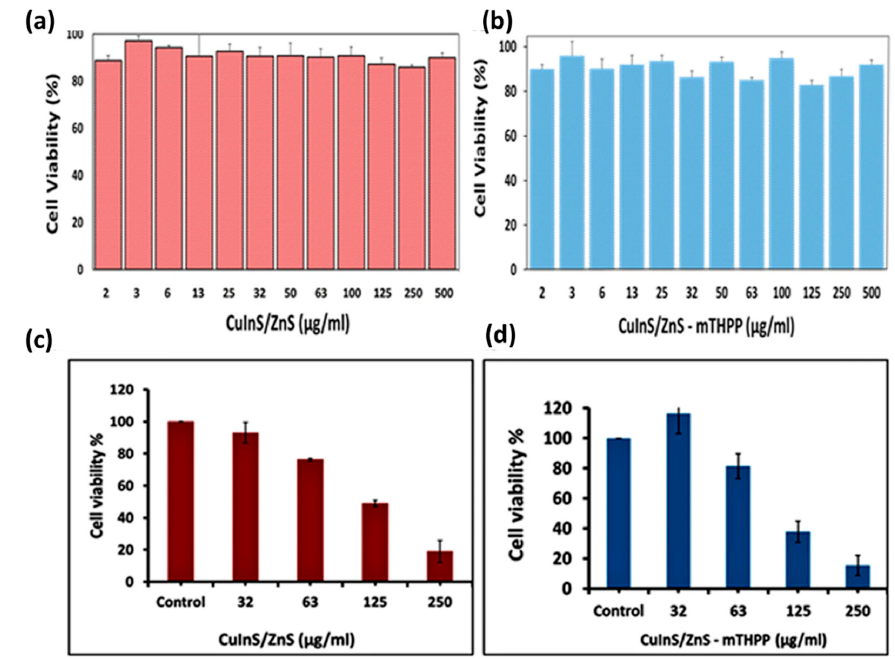
Figure 19. Cell viability study of ( a ) CuInS 2 /ZnS QDs and ( b ) CuInS 2 /ZnS-mTHPP(meso (hydroxyphenyl) porphyrin) conjugate QDs against BHK21 normal cell line and Cytotoxicity studies of ( c ) CuInS/ZnS QDs and ( d ) CuInS/ZnS—mTHPP conjugate against THP-1 cancer cell line [18].